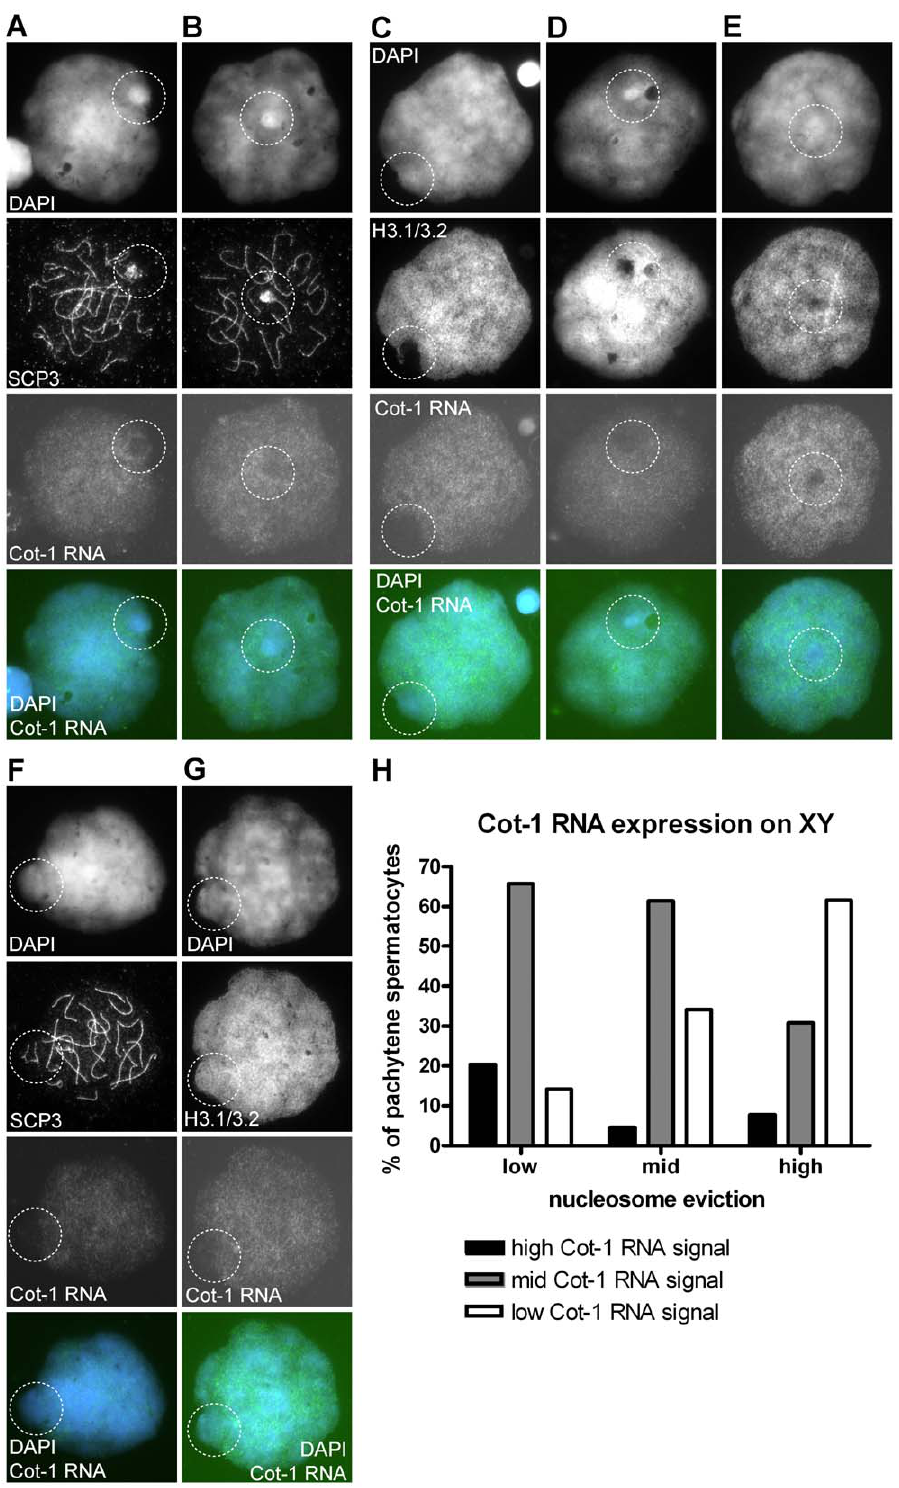
Figure 5. Cot-1 RNA expression in pachytene spermatocytes. A Late pachytene nucleus displaying a low Cot-1 RNA signal on XY. B Late pachytene nucleus displaying a higher Cot-1 RNA signal on XY. C Late pachytene nucleus showing a high degree of H3.1/3.2 nucleosome eviction and a low Cot-1 RNA signal on XY. D Late pachytene nucleus showing an intermediate (mid) degree of H3.1/3.2 nucleosome eviction and intermediate (mid) Cot-1 RNA signal on XY. E Late pachytene nucleus showing a low degree of nucleosome eviction and high Cot-1 RNA signal on XY. F Early pachytene nucleus displaying low Cot-1 RNA expression on XY. G Early or mid pachytene nucleus before H3.1/3.2 nucleosome eviction but with an intermediate (mid) Cot-1 RNA signal. H Histogram showing the relation between the degree of H3.1/3.2 nucleosome eviction and the level of Cot-1 RNA signal (bars) (n=134, P2, C2,3). doi:10.1371/journal.pone.0031485.g005 PLoS ONE |